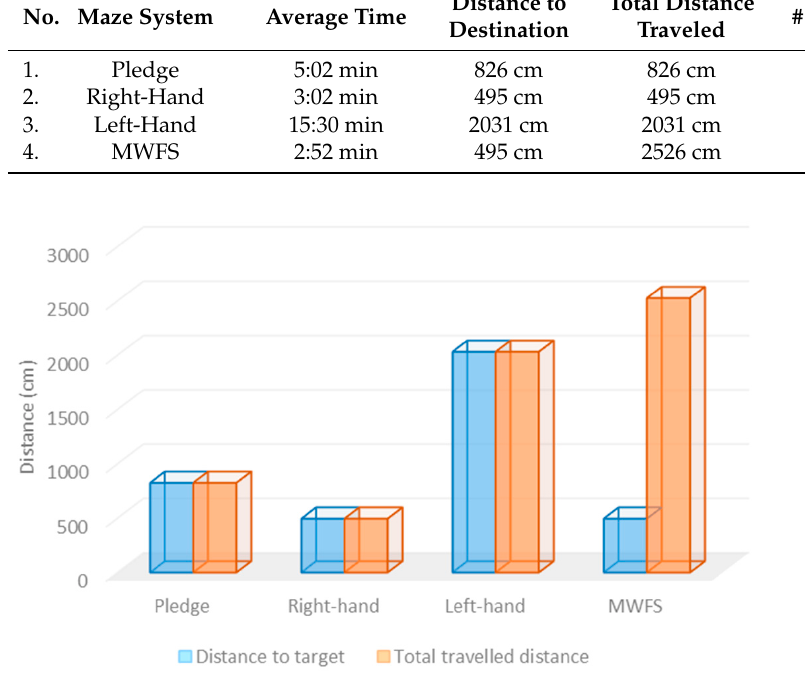
Figure 11. The total traveled distance of the solver robot for 4 algorithms in testbed # 2.